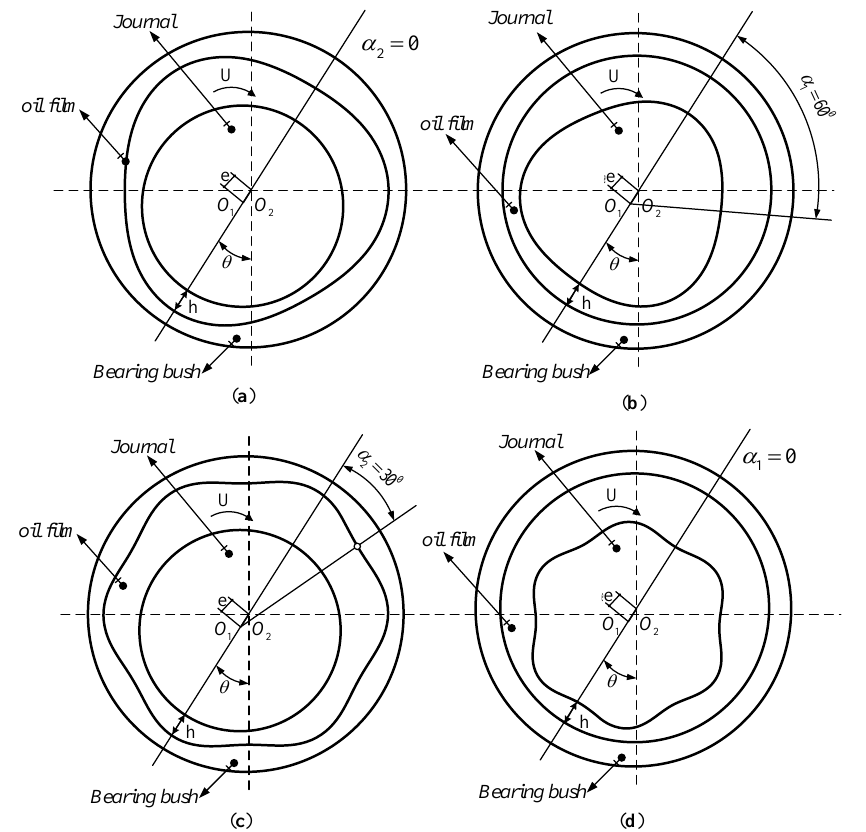
Figure 6. The position of the bearing bush ( a , c ) and the journal ( b , d ), corresponding to the minimum value of F .